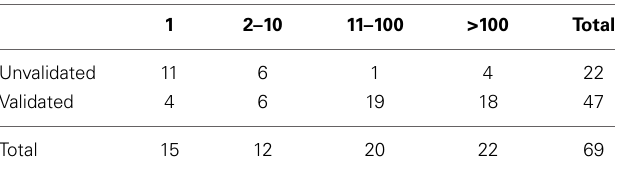
Table 5 | Overview of the number of validated HPV types according to the amount of detected